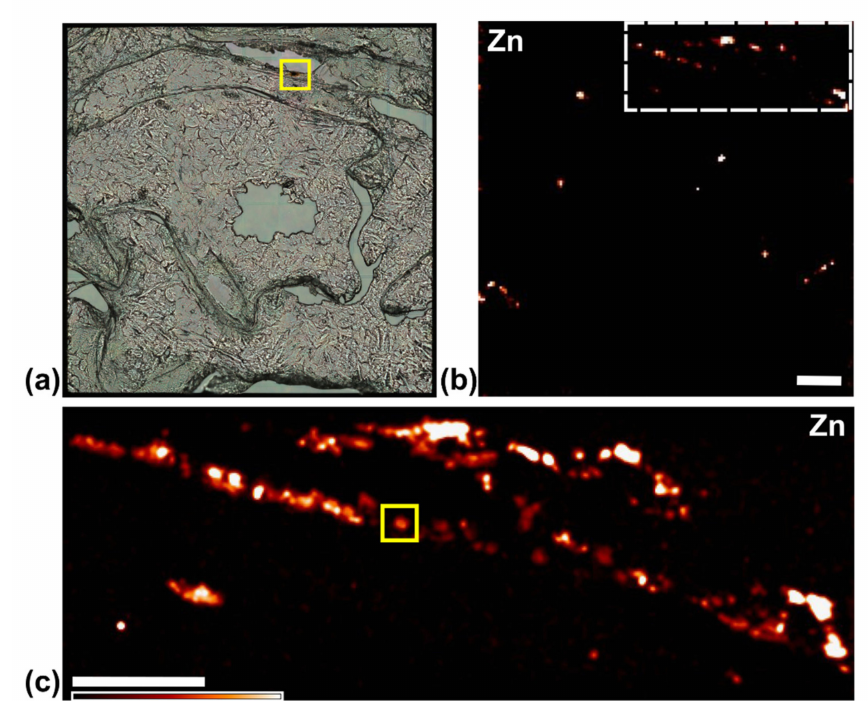
Figure 8. Overview images of a 5 µ m-thick slice from the cell cluster sample on an XFM compatible “window” with 1.5 × 1.5 mm 2 Si 3 N 4 film. ( a ) Visible light image of the entire window; ( b ) 2D fluorescence mapping of the entire window showing the cell distribution, represented by Zn signal; the rectangle region indicated by white dashed lines was zoomed in by another 2D scan with smaller pixel size, as Zn signal shown in ( c ). The yellow squares in both ( a , c ) indicated the same single cell, which was later on imaged tomographically in 3D at the BNP instrument. Color sale bar goes from no signal (black) to highest signal (white). The scale bars in (b) and (c) are 200 µ m.